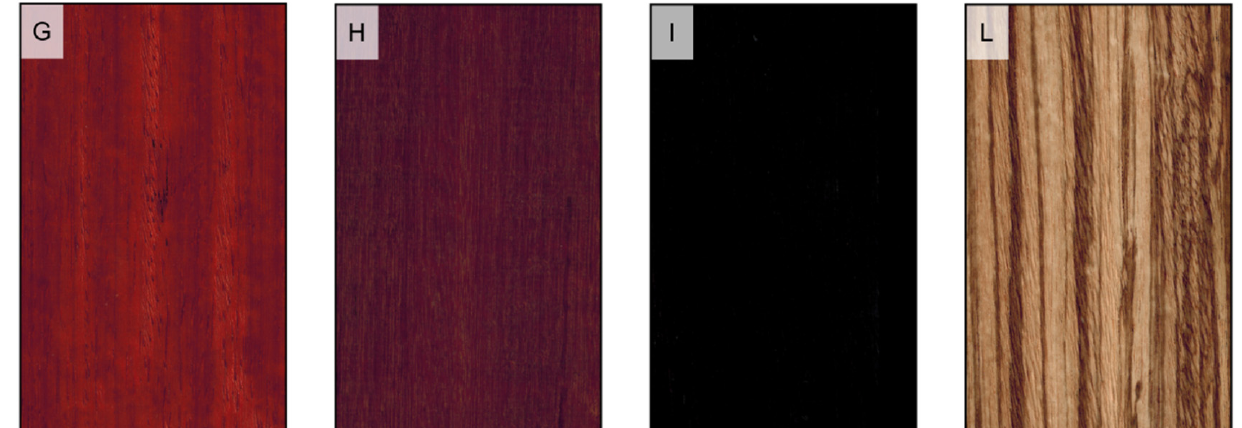
Figure 2. Sapwood and heartwood color. ( A ) heartwood color darker than sapwood color ( Larix decidua ); ( B ) heartwood and sapwood of the same color ( Picea abies ); ( C ) heartwood white ( Aesculus hippocastanum ); ( D ) heartwood brown ( Tectona grandis ); ( E ) heartwood yellow ( Buxus sempervirens ); ( F ) heartwood green ( Bulnesia sarmientoi ); ( G ) heartwood red ( Pterocarpus soyauxii ); ( H ) heartwood purple ( Peltogyne paniculata ); ( I ) heartwood black ( Diospyros ebenum ); ( L ) heartwood variegated ( Microberlinia brazzavillensis ). The occurrence of extractives defines heartwood color and plays a crucial role in determining the aesthetic value of timber. While woods with brown, white, and gray hues are common, red, yellow, black, purple, pink, green, orange, and variegated ones are less common to rare (Table 4 and Figure 2). During MWI, cautiousness must be paid when evaluating wood color (Table 1, features 59 to 64) because it might have been altered by different factors: color can change from green to dry wood state, moreover, dry wood color is often subject to changes resulting from exposition to light and/or contact with oxygen (air) [3]; treatments can be applied to modify it, for instance, to minimize the difference between sapwood and heartwood, or to confer valuable tones [37,38]. Table 4. Examples of species for different heartwood